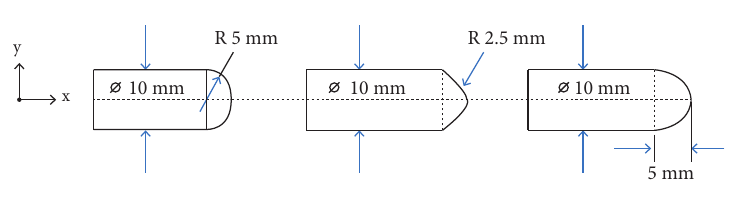
Figure 2. Three different pintle head